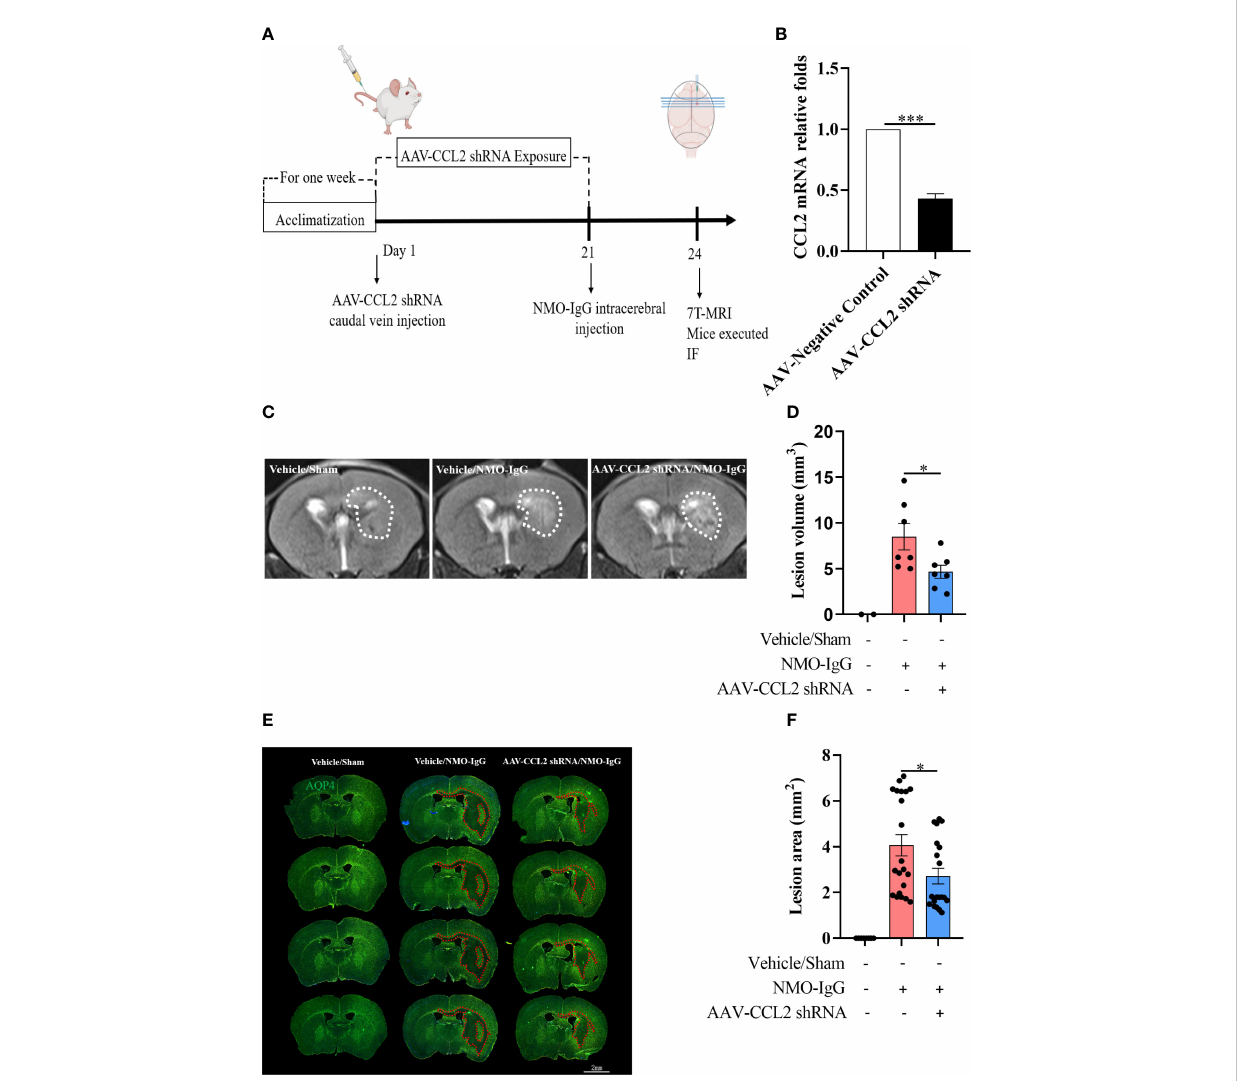
FIGURE 5 Selective knockdown of CCL2 gene expression in astrocytes by AAV decreased brain focus lesions and AQP4 loss. (A) The schematic shows the experimental design. C57BL/6 mice received AAV (pAAV-GfaABC1D-EGFP-3X fl ag-miR30shRNA (CCL2)-WPRE) containing an astrocyte-speci fi c promoter by injection into the tail vein on day 1 (n = 7 per group), which can signi fi cantly reduce the expression of the CCL2 gene in brain astrocytes. Mice received vehicle or NMO-IgG (intracerebral injection) on day 21. At the indicated time points after NMO-IgG administration, mice were subjected to 7.0-T MRI and immuno fl uorescence staining. (B) Ef fi ciently reduces the CCL2 mRNA expression in astrocytes by AAV-CCL2 shRNA injection. (C) On day 24, mice underwent 7.0-T MRI, and T2-weighted images showed lesion areas dotted with white dashed lines. (D) Quanti fi cation of the lesion volume induced by NMO-IgG after receiving AAV-CCL2 shRNA or not. Compared with the vehicle/NMO-IgG group, the lesion volume in the AAV-CCL2 shRNA/NMO-IgG group reduced signi fi cantly. (E) Immunostaining of AQP4 in NMO lesions on day 24. Red dash lines delineate the lesion area. Scale bar = 2 mm. (F) Quanti fi cation of the lesion area with AQP4 loss in the sections of vehicle/NMO-IgG and AAV- CCL2 shRNA/NMO-IgG group mice. Data are given as mean ± SE. * p < 0.05, *** p <